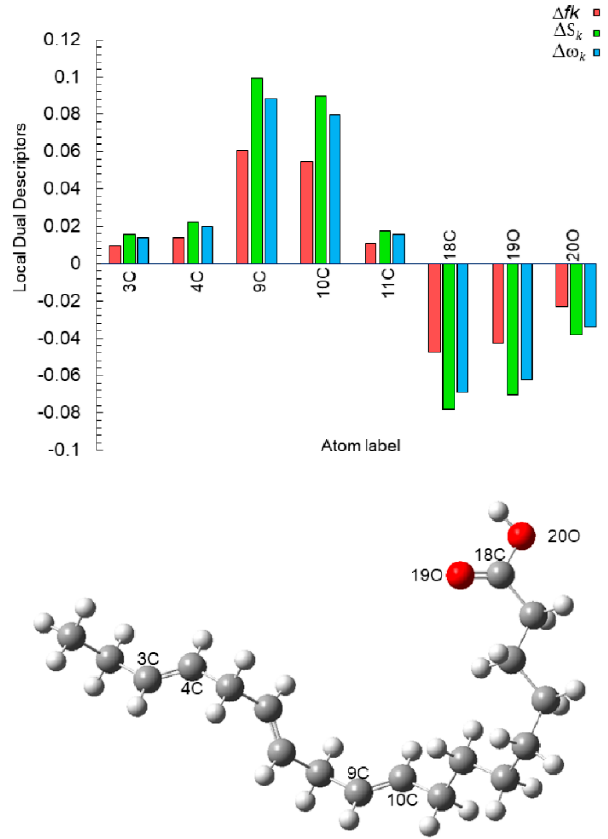
Figure 12. Graphical representation of the dual descriptors ( ∆ f k , ∆ S k and ∆ ω k ) for the most active sites of neutral α -linoleic acid molecule. Table 6. Calculated quantum chemical parameters for the protonated α -linolenic acid